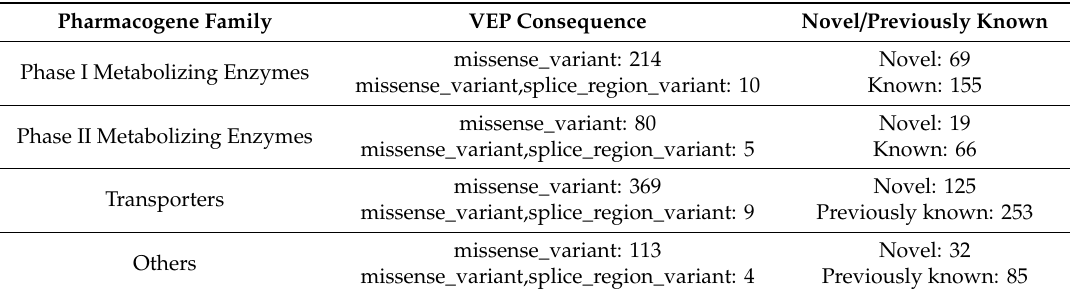
Table 1. Count of predicted protein damaging variants in four main PGx gene families according to their VEP consequences and their characterization as novel or known. Abbreviations: VEP, Variant E ff ect